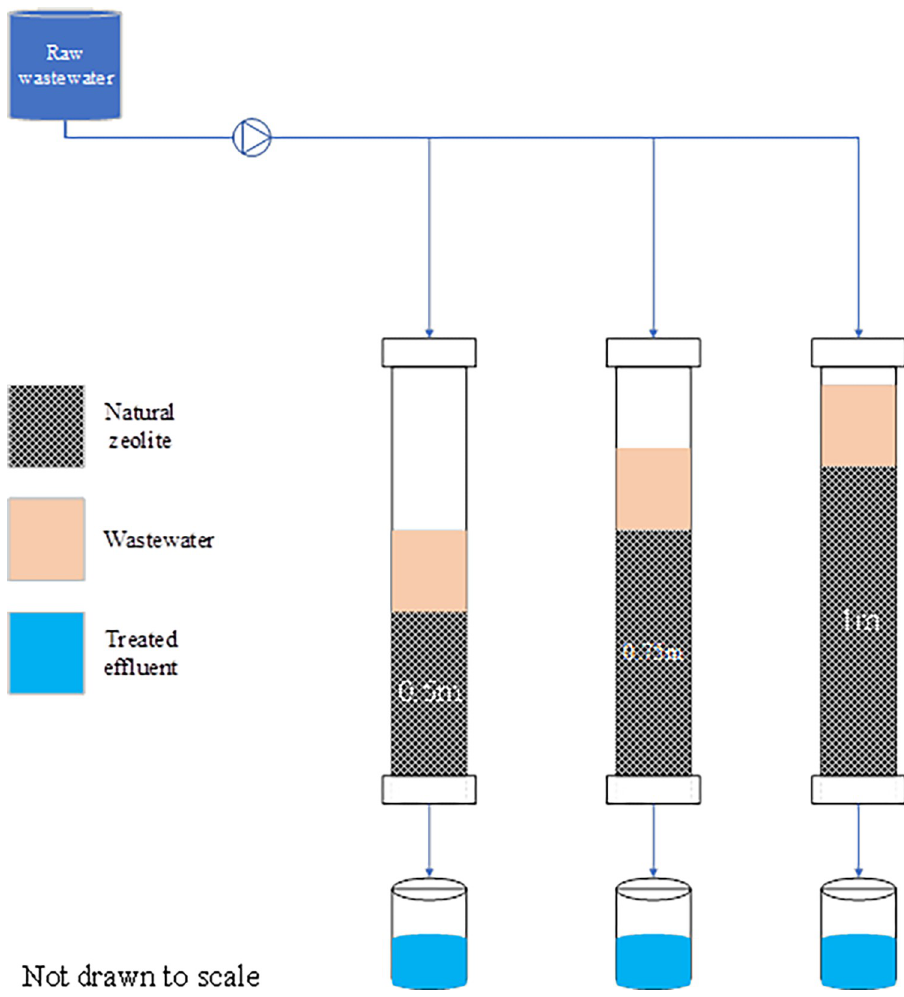
Fig 1. Experimental setup.